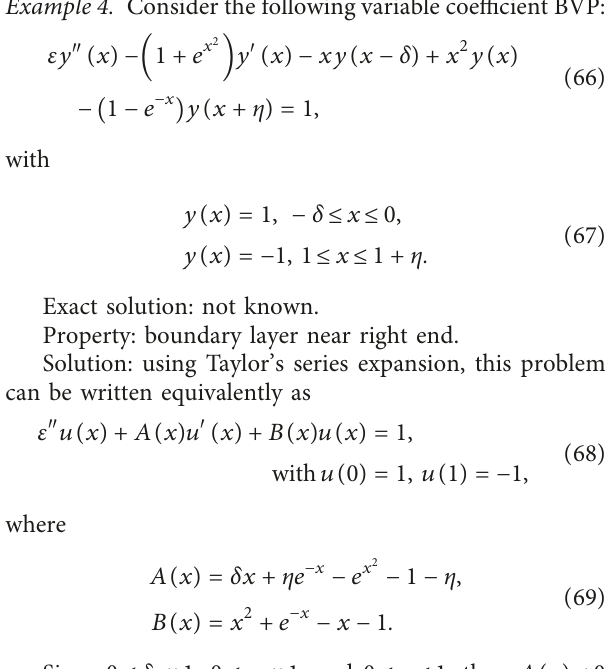
Figure 5: Approximate solution of Example 3 for different values of η